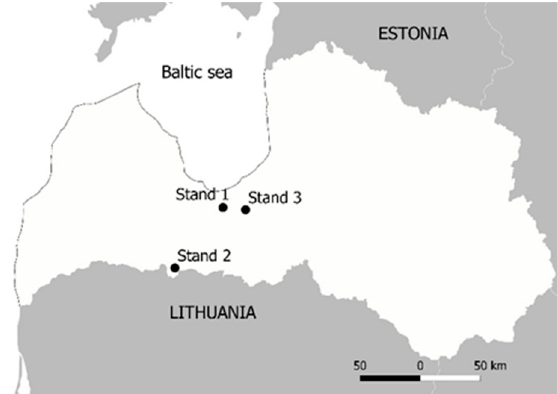
Figure 1. Location of the study sites in the central part of